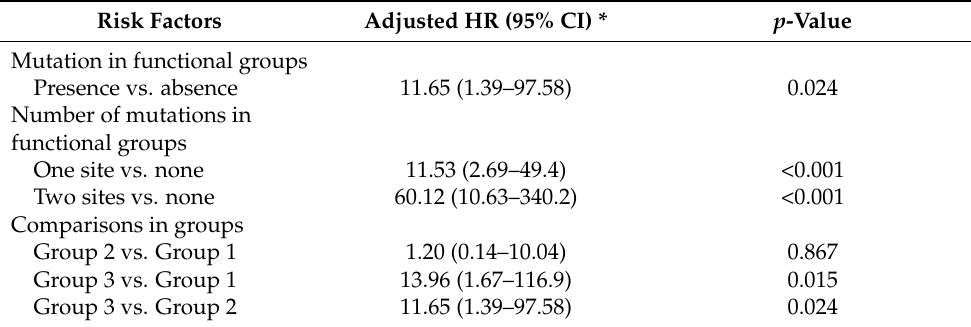
Table 2. Prognostic effects of mutations in functional groups on survival in patients with advanced PTCs harboring the BRAF V600E